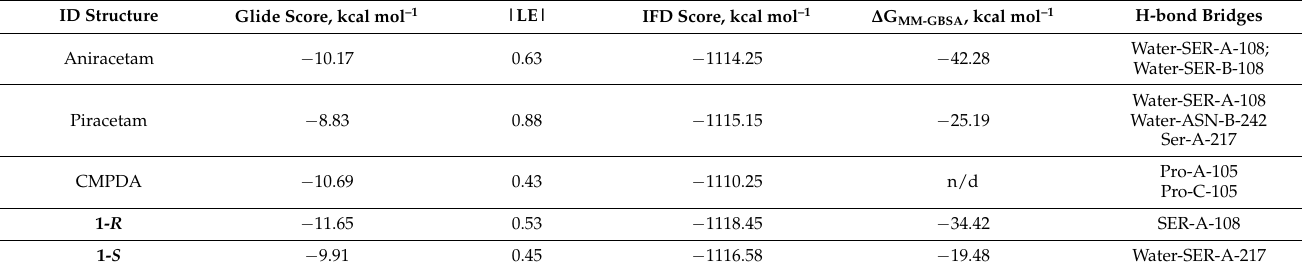
Table 7. Results of the docking procedure at the active site of the ligand-binding domain (S1S2) of the AMPA receptor. ID